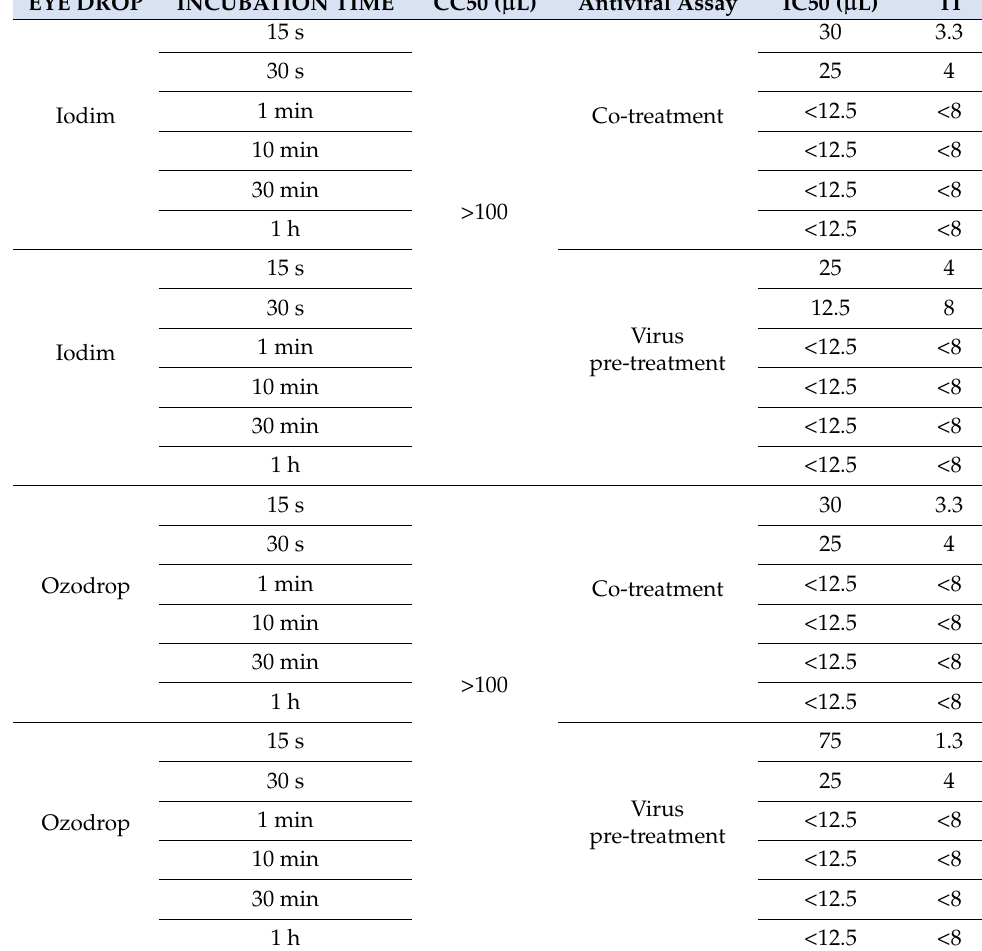
Table 2. CC50, IC50 and TI corresponding to each incubation time calculated for Iodim and